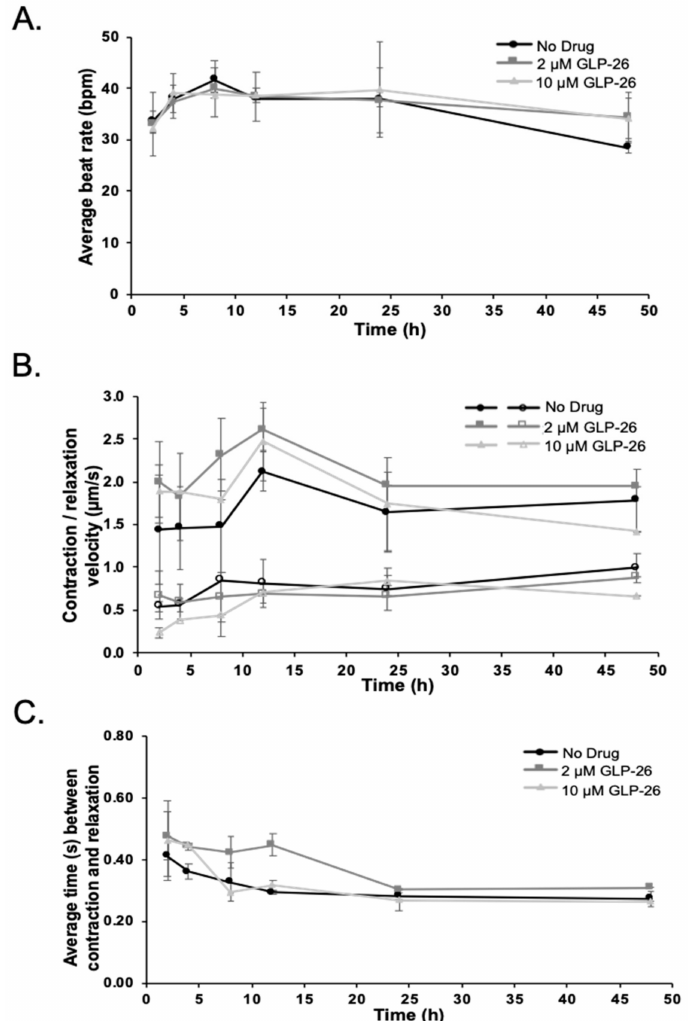
Figure 6. Cardiomyocytes treated with 2 or 10 µ M of GLP-26. ( A ) Beat rate. ( B ) Force of cardiomy- ocytes contraction and relaxation (solid markers for contraction, open markers for relaxation). ( C ) Contraction to relaxation time